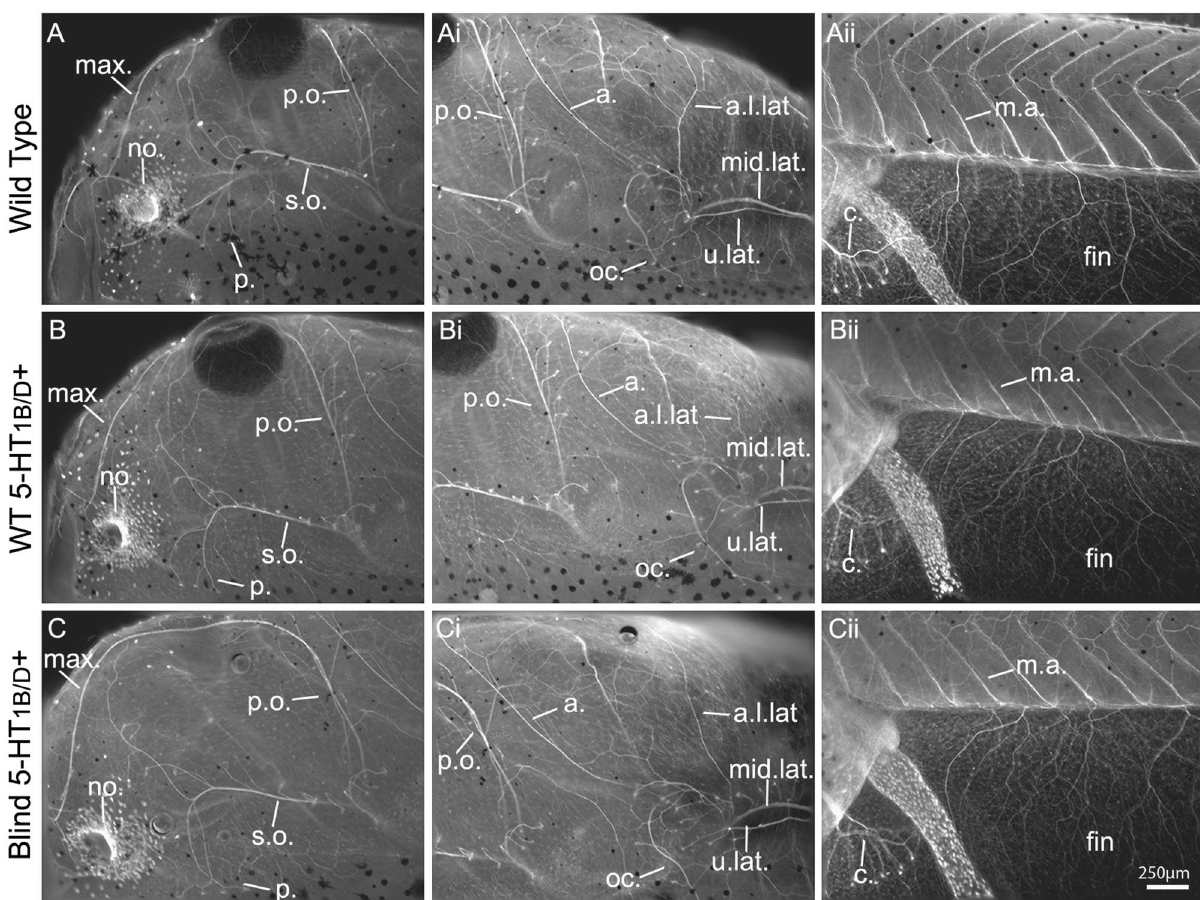
Fig. 4 5-HT 1B/D activation does not alter host innervation. a i – iii Immunohistochemistry against acetylated-tubulin allowed visualization of lateral line components, nostrils, and motor axons. When comparing wild-type animals to 5-HT 1B/D -activated ( b i – iii) or 5-HT 1B/D -activated blind animals ( c i – iii), no differences were observed between treatments. a . aortic lateral line, a.l.lat anterior lower lateral line, c. caudal lateral line, m. a. motor axon, max. maxillary lateral line, mid.lat. middle lateral line, o.c . occipital lateral line, no. nostril, p. parietal lateral line, p.o. post-orbital lateral line, s.o. supra-orbital lateral line, u.lat. upper lateral